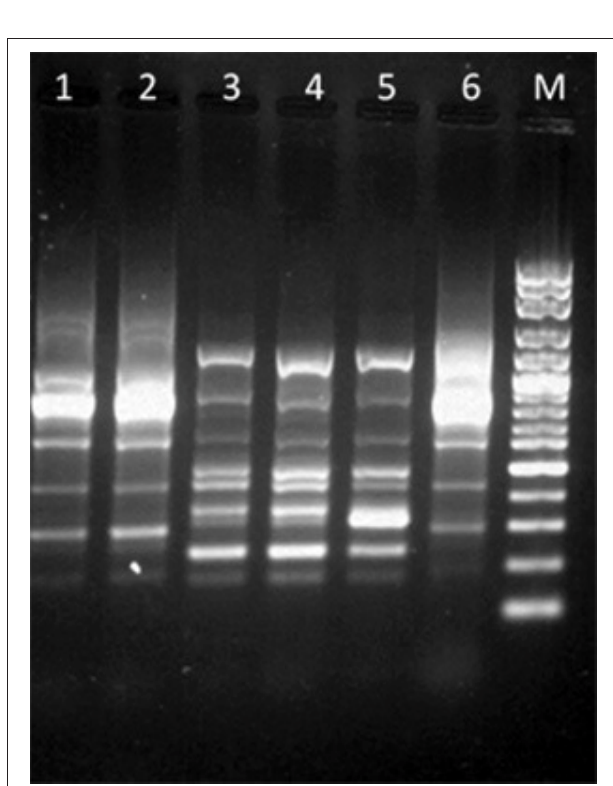
FIGURE 3 | RAPD-PCR profiles among isolates after addition of EO or limonene. Lane 1: EC9 after addition of EO; lane 2: EC9 after addition of limonene; lane 3: EF1 after addition of EO; lane 4: EF1 after addition of limonene; lane 5: EF1 isolate without treatment; lane 6: EC9 isolate without treatment; lane M: Molecular marker, 100 bp DNA